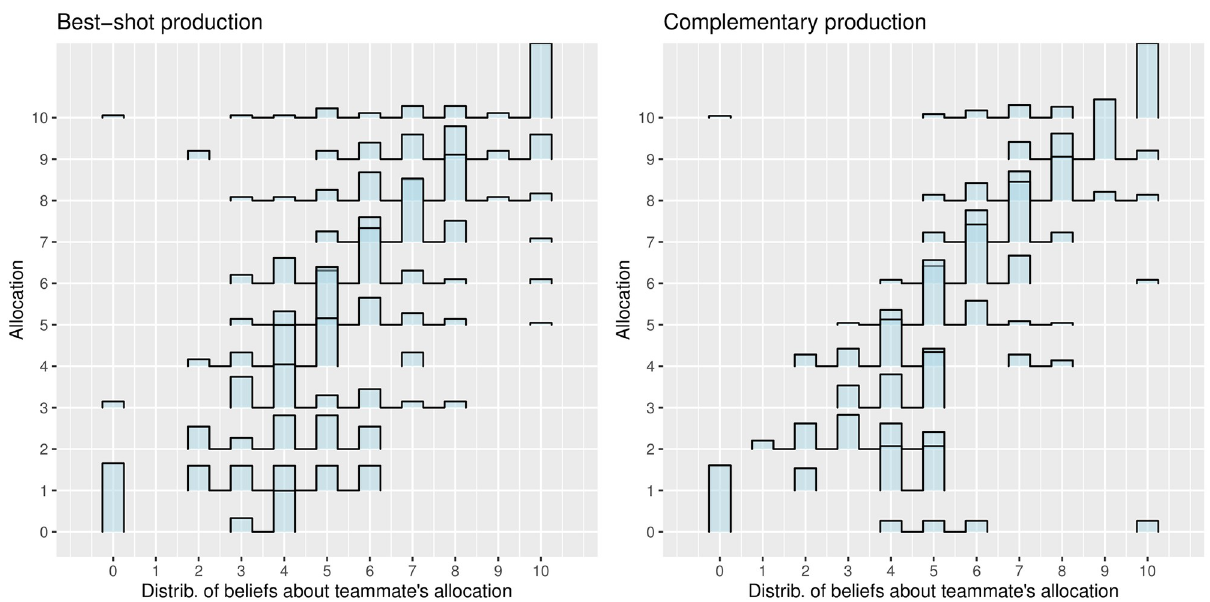
Fig 3. Effort contribution levels conditional on beliefs about teammate’s contribution. Panels correspond to team production functions. high density in the upper-left and bottom-right corners, reflecting the incentives to anti-coor-